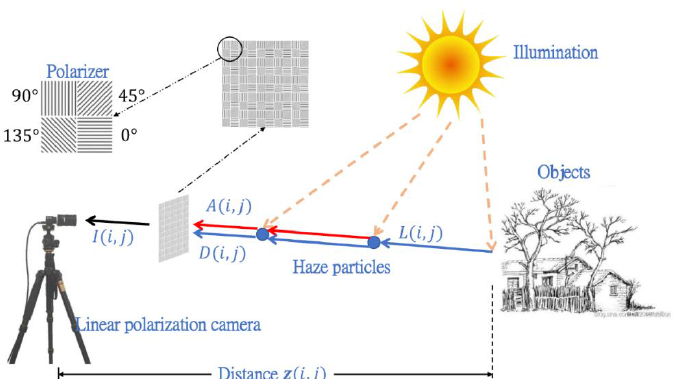
Figure 10. The physical model of atmospheric scattering and polarimetric imaging. L(i, j): non-polarized light, A(i, j): Airlight, D(i, j): direct light, I(i, j): the irradiance [51].